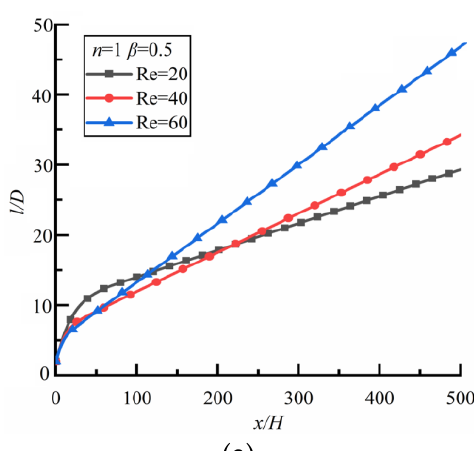
Figure 9. Changes of l/D along flow direction for different Re ( n =1). ( a ) β =0.5, ( b ) β =2.